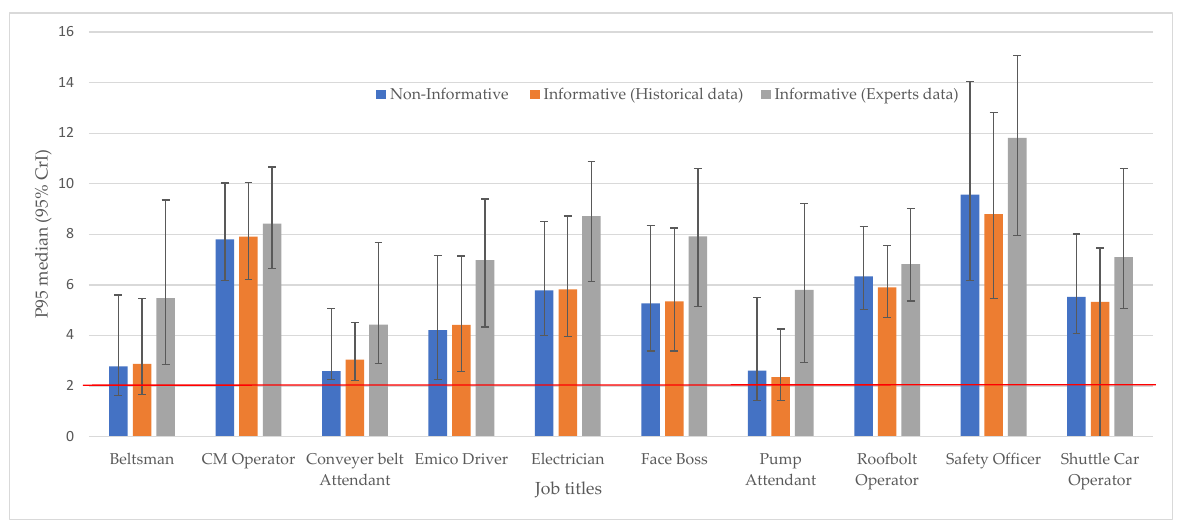
Figure 1. The comparison of the patterns of the posterior median (95% CrIs) of the P95 for non ‐ informative and informative (historical and expert data) distribu ‐ tions of the TWA8h dust concentrations across the job titles. The red horizontal is the SA OEL = 2 mg/m 3 .